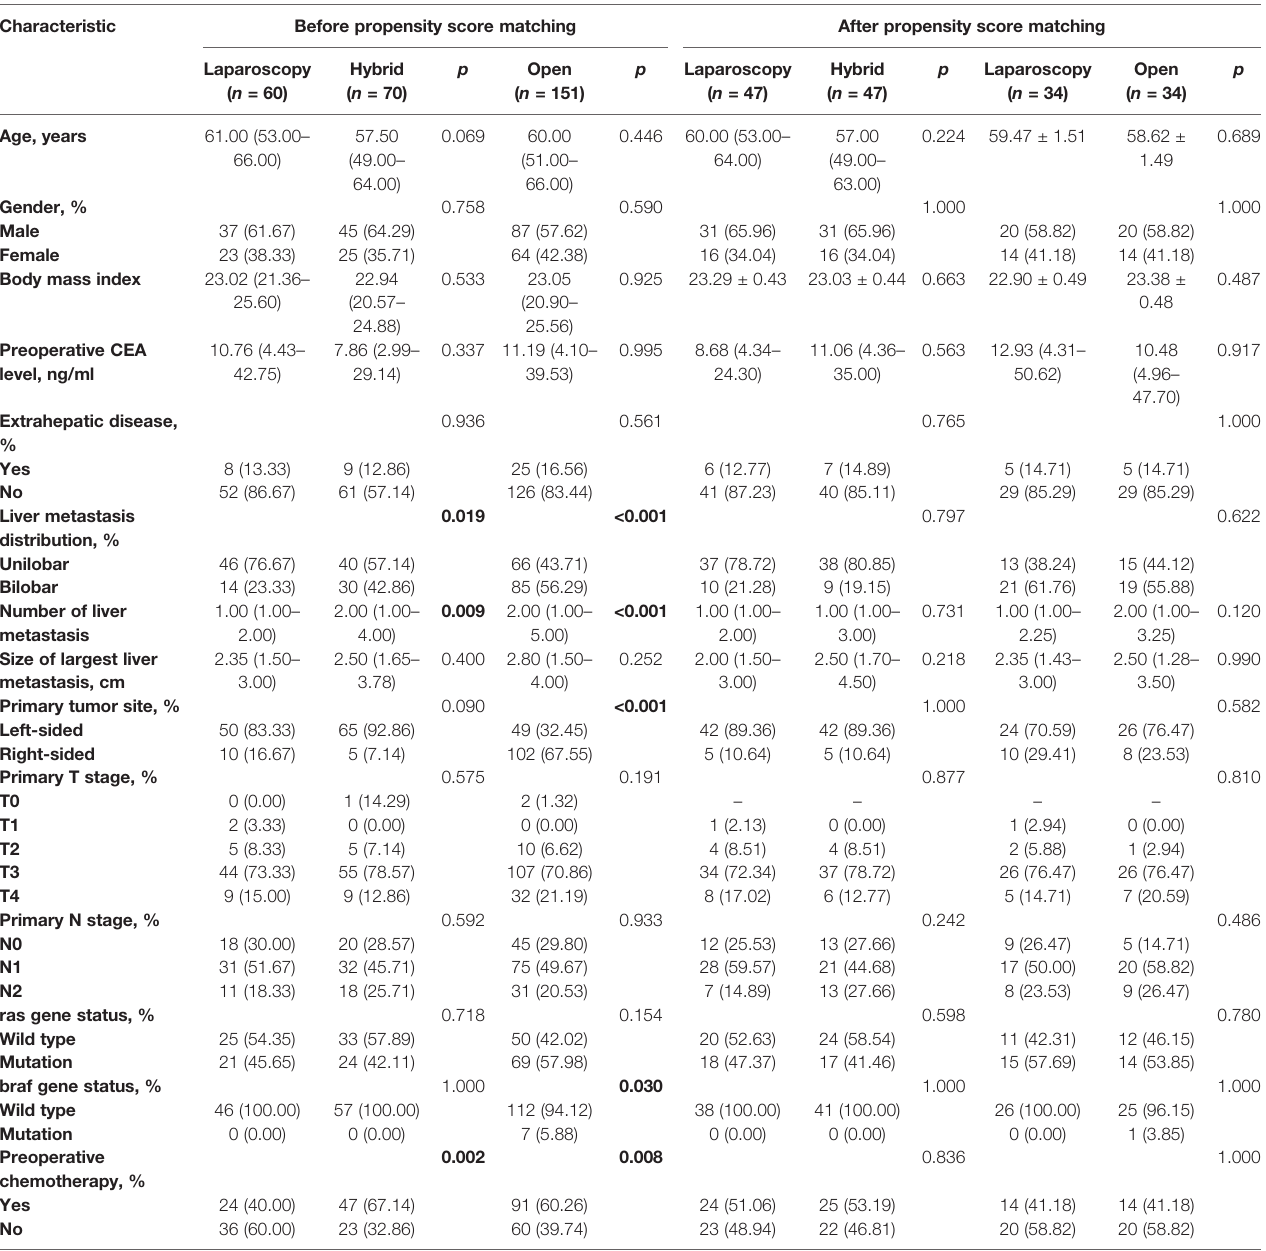
TABLE 1 | The clinicopathological characteristics of patients.